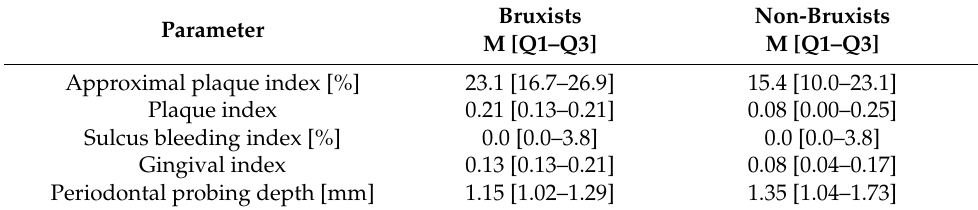
Table 1. Oral hygiene and periodontal status.